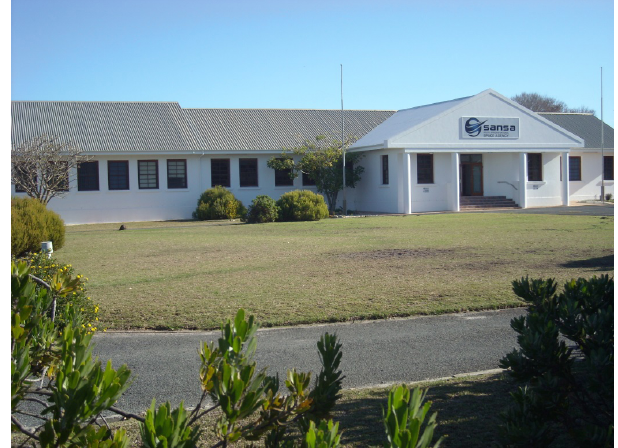
Figure 3. The present main building of the SANSA Space Science in Hermanus, current home institution of Hermanus Magnetic Ob-